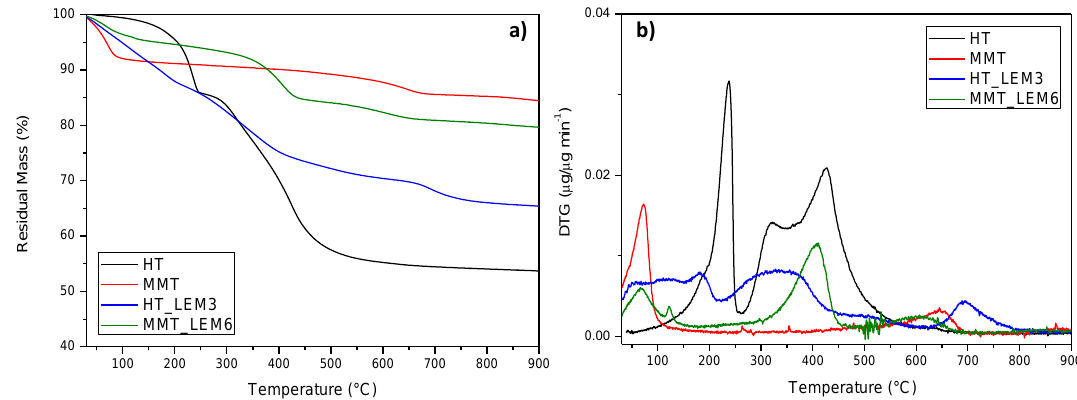
Figure 5. ( a ) TG ( a ) and DTG ( b ) results obtained for HT, MMT and lemon hybrid pigments (HT-LEM Figure 5. (a) TG (a) and DTG (b) results obtained for HT, MMT and lemon hybrid pigments and (HT-LEM and MMT-LEM).